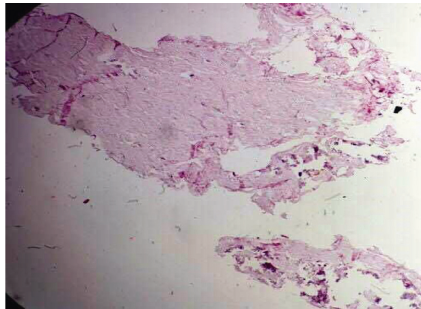
Figure 2: Magnetic resonance cholangiopancreatography (MRCP) demonstrating the 3-line sign typical for ascaris worm (arrow).